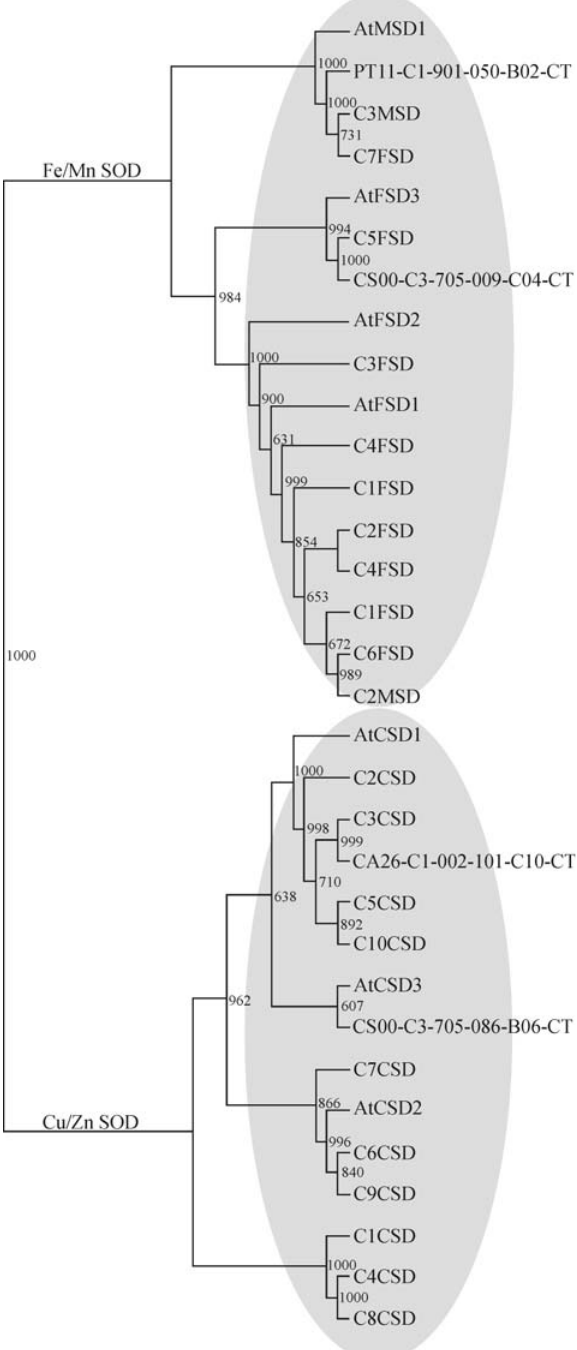
Figure 6 - Phylogenetic analysis of citrus superoxide dismutase (SOD) homologs and the Arabidopsis thaliana prototypical SOD proteins. Neighbor-joining trees for citrus deduced amino acid and Arabidopsis full length sequences aligned with ClustalX are shown. Bootstrap values are indicated above each branch. At, Arabidopsis thaliana ; C Number, contig number; CSD, copper/zinc superoxide dismutase; FDS, iron superoxide dismutase; MDS, manganese superoxide